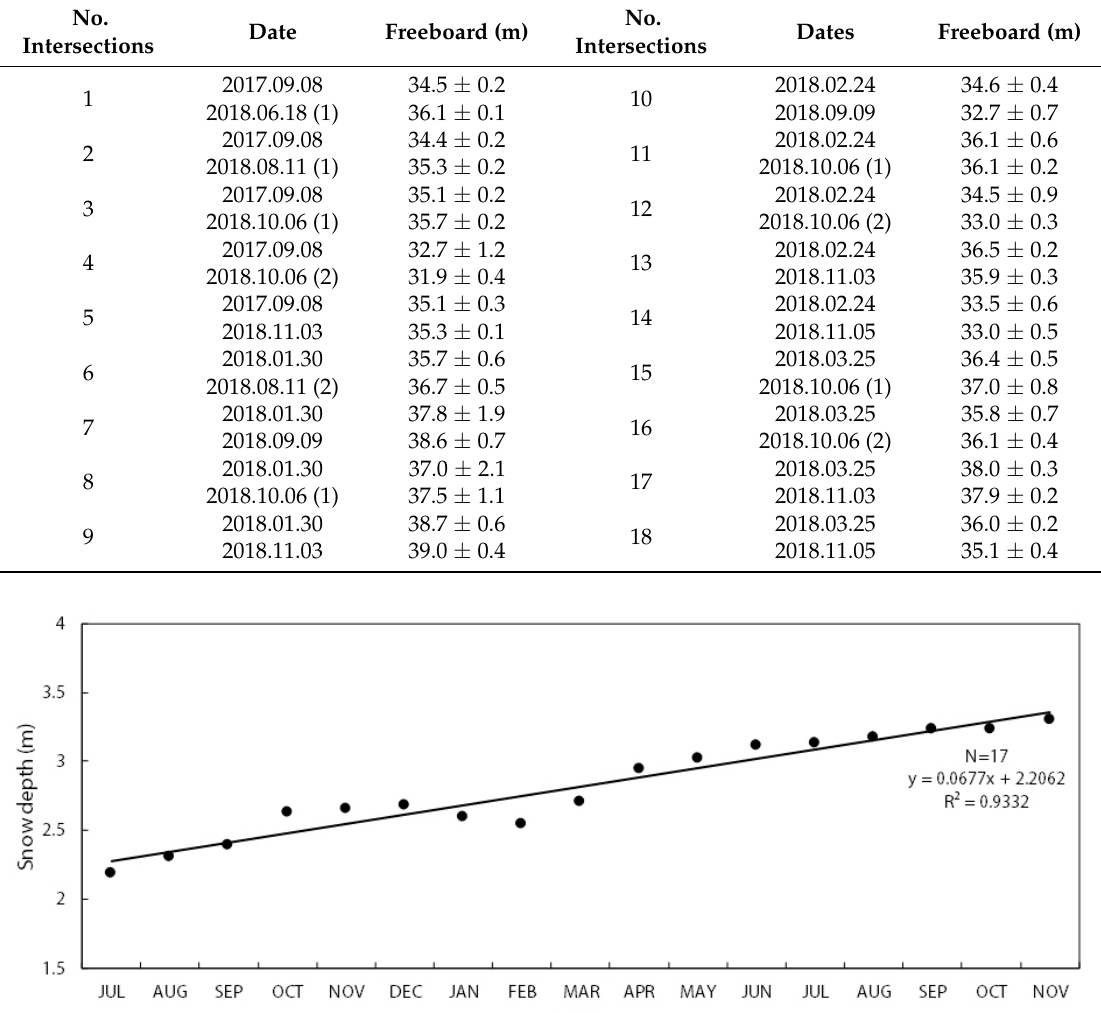
Table 1. The freeboards of iceberg A68A at the intersections of different CryoSat-2 profiles shown in Figure 2. No.